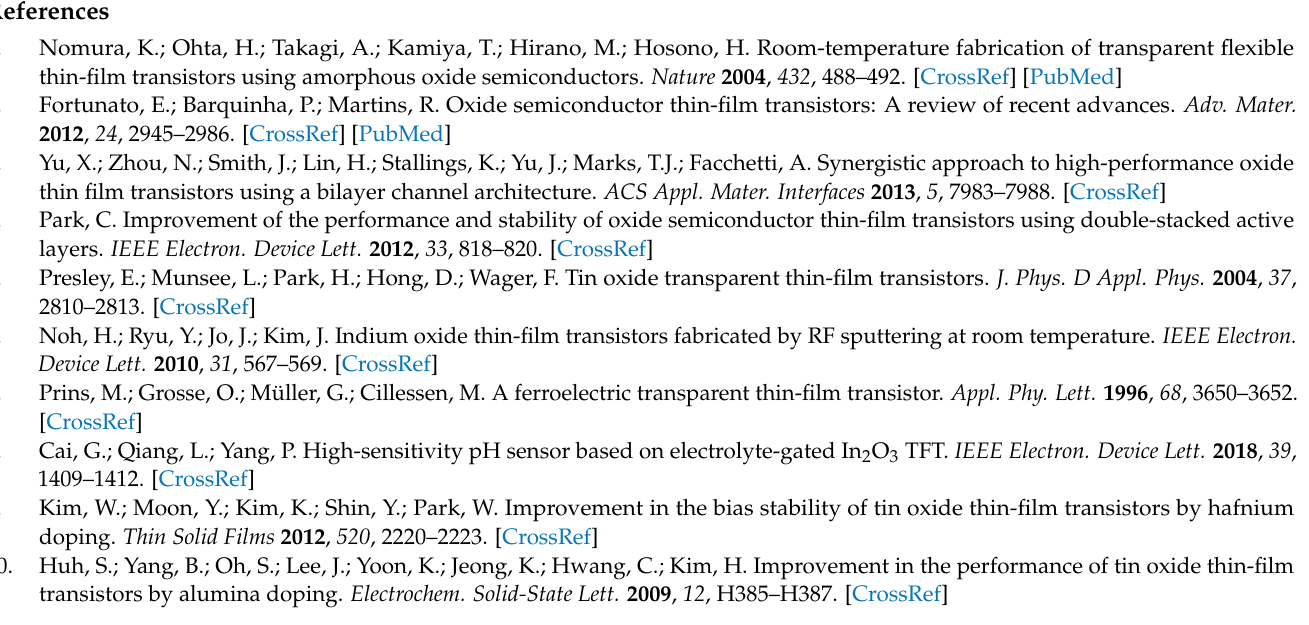
Figure 9. The band structures of ZnO and ZnO:H prepared at H 2 /(Ar + H 2 ) = 0.13%: ( a ) before contact and ( b ) after contact.